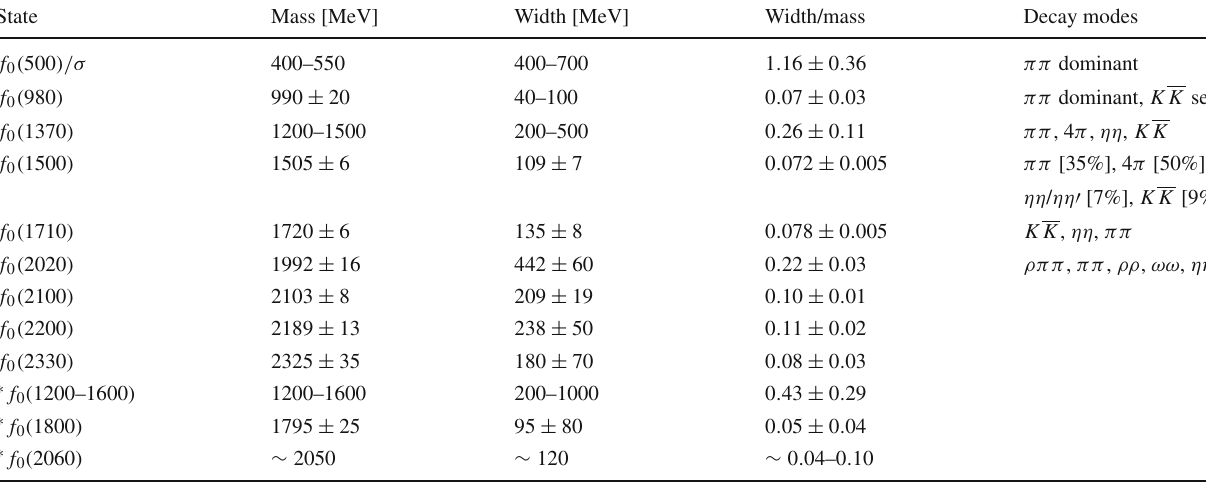
Table 16 All the f 0 states as listed by the PDG. The last few states, marked here by asterisk, are classified as “further